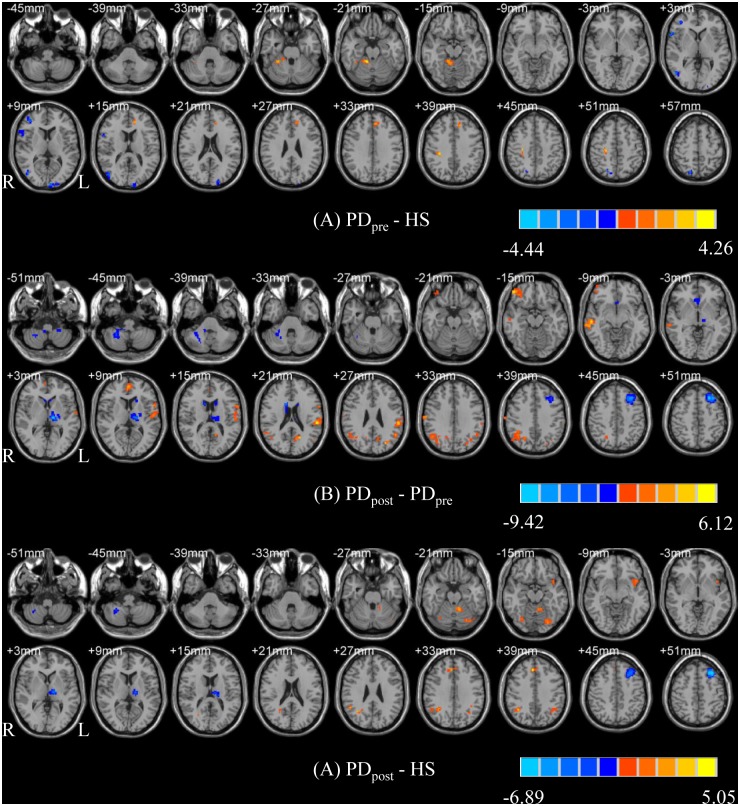
T- statistics maps of lPDpre versus HS (A), lPDpost−lPDpre (B), and lPDpost−HS (C).T-score bar: hot and cold colors indicate ReHo increases and decreases, respectively. lPD: patients receiving left-side VIM thalamotomy.